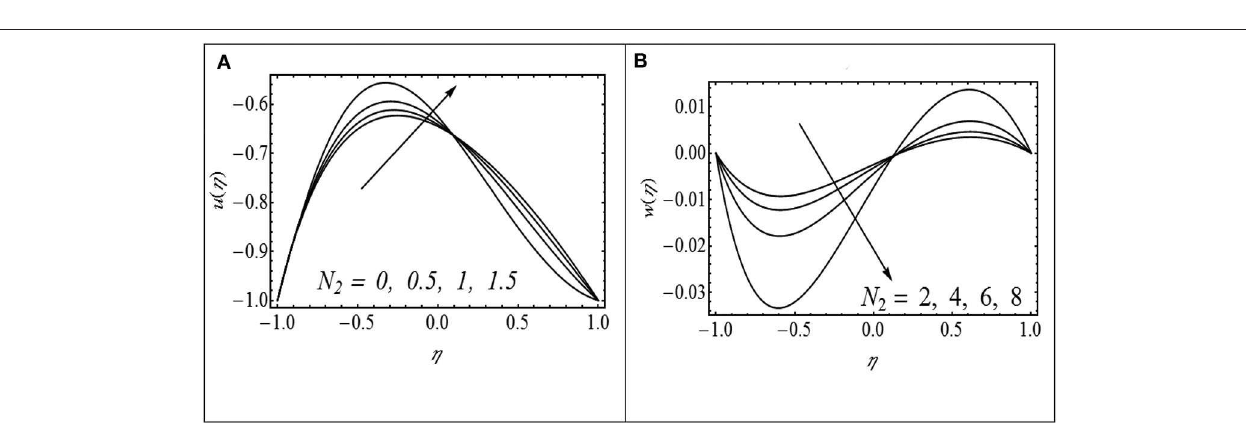
Frontiers in Physics |